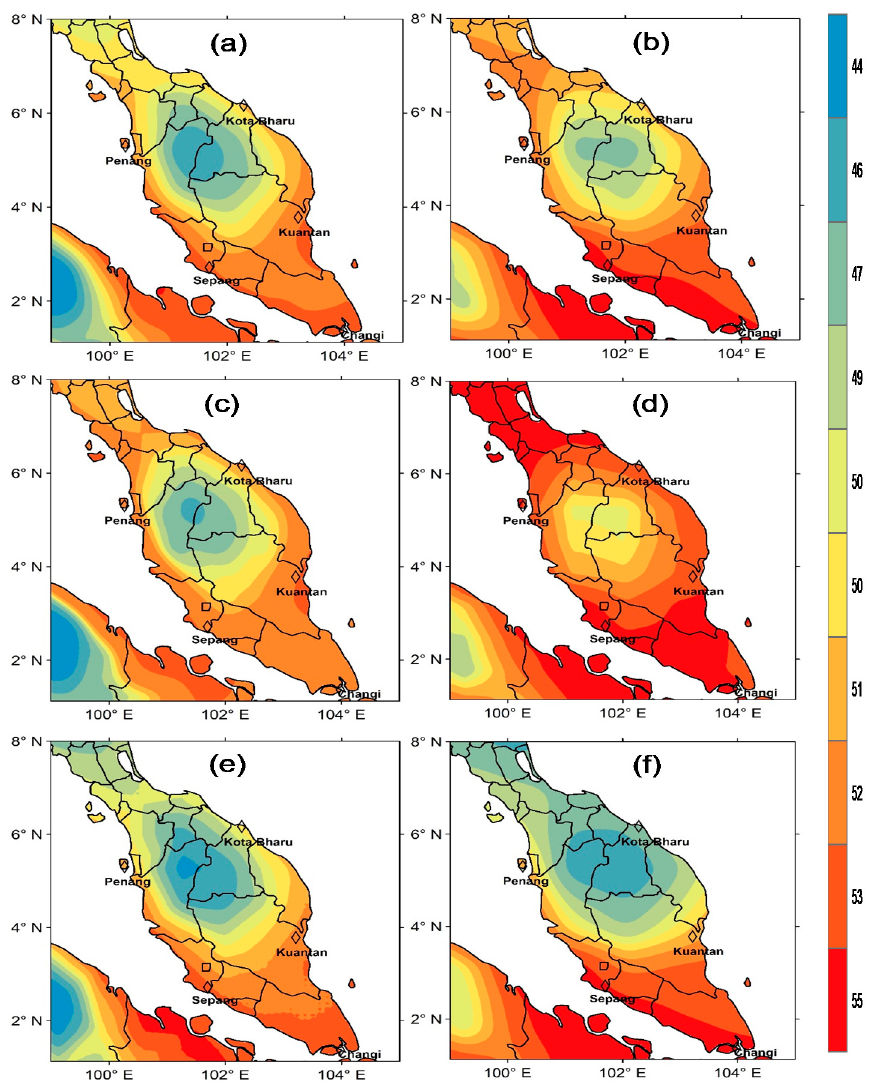
Figure 5. Comparison of the spatial evolution of integrated water vapour (IWV) between ( a , c , e ): ERA-Interim (1988–2018) and ( b , d , f ): CM-SAF (2001–2011). The first row is for mean annual values, while the second and third rows are for SWM and NEM, respectively.